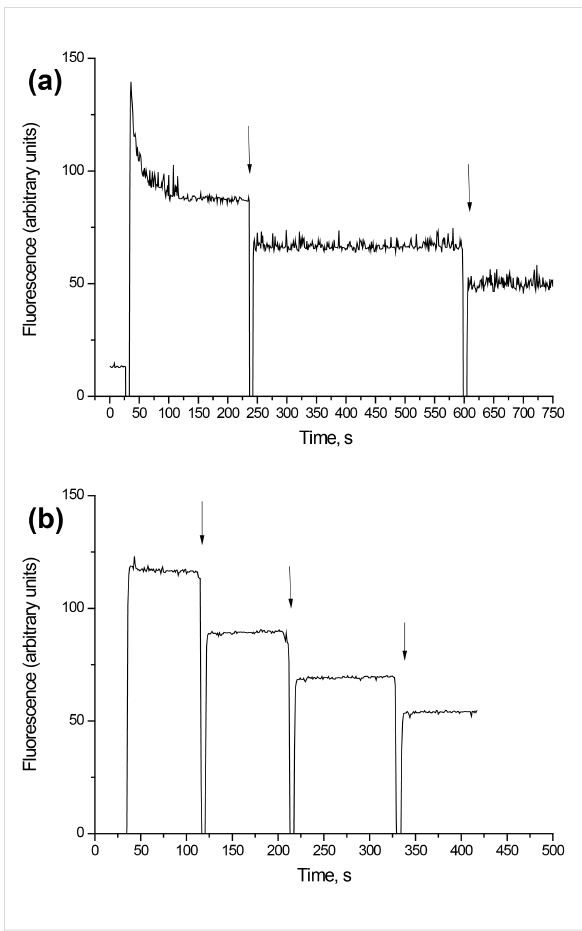
Figure 4: Ambient level of L-[ 14 C]glutamate in the control nerve terminals (solid line), and in the presence of D-mannose-coated γ -Fe 2 O 3 nanoparticles (250 µg/mL) (dotted line). After loading with L-[ 14 C]glutamate (1 nmol/mg of protein, 238 µCi/mmol), aliquots of synaptosomes were collected at different time intervals, centrifuged, and the radioactivity was determined as described in section Experi- mental. Total synaptosomal L-[ 14 C]glutamate content was equal to 200,000 ± 15,000 cpm/mg protein. Data are means ± SEM of five independent experiments, each performed in triplicate.